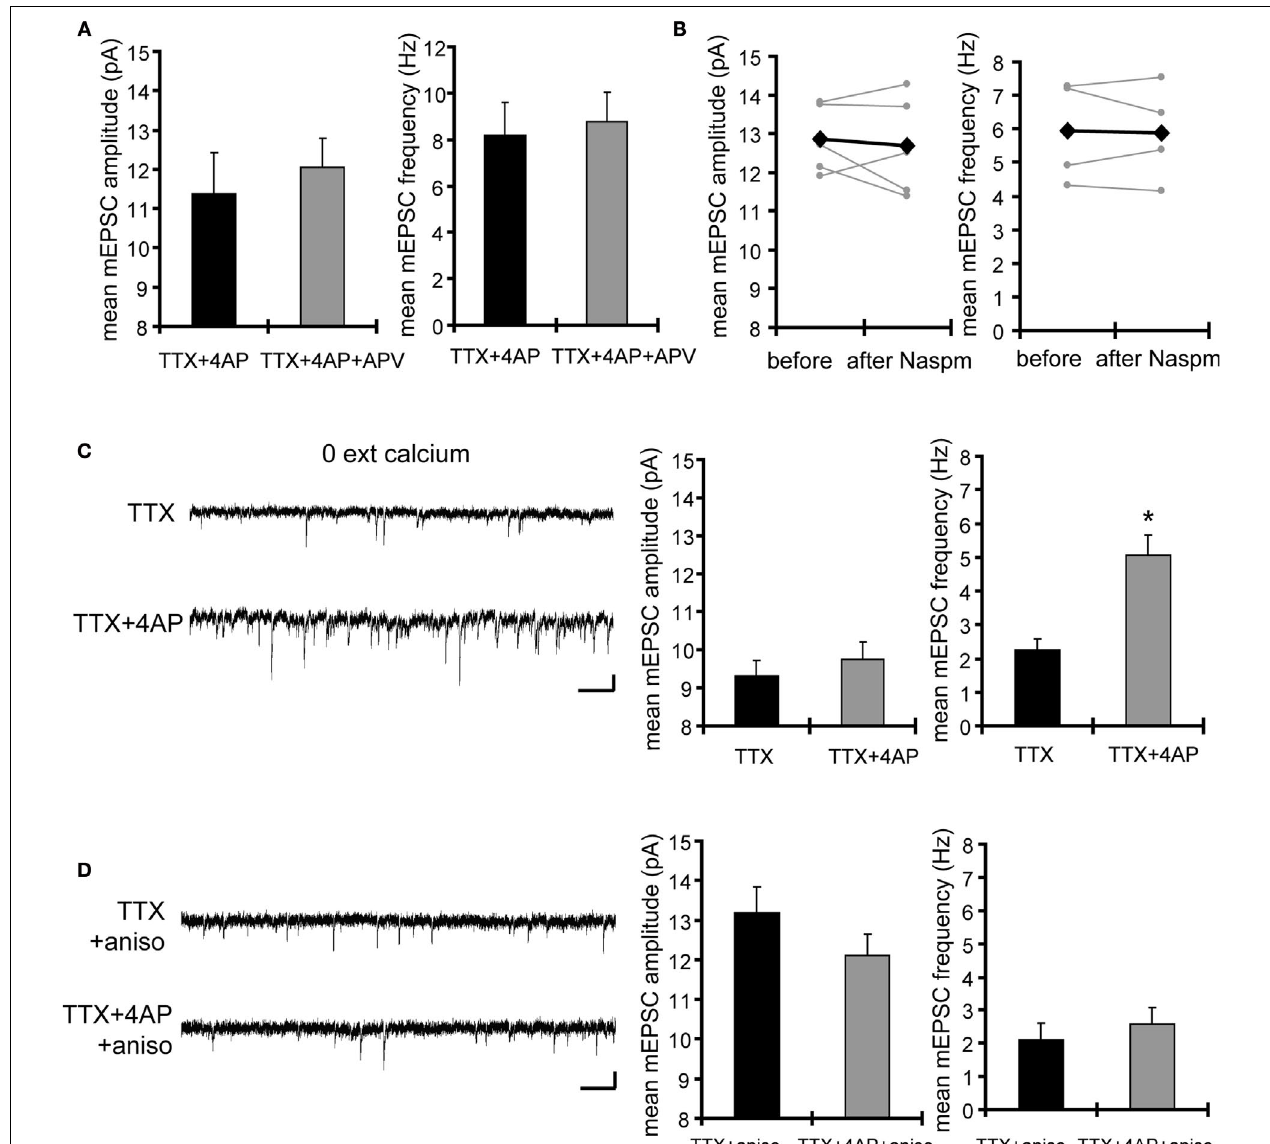
FIGURE 4 | Synaptic scaling induced by A-type channel blockade is protein synthesis dependent, but calcium-signaling independent. (A) Co-treatment with the NMDA receptor antagonist, APV (50 µM), did not infl uence synaptic scaling by A-type channel blockade ( n = 7 for each). No apparent difference in membrane properties was observed between experimental groups ( Table 1 ). (B) Synaptic scaling induced by A-type channel blockade does not require GluR2-lacking receptors. After 12-h treatment with TTX + 4AP, mEPSCs were recorded and the acute infl uence of Naspm (10 µM) application was examined. Data from individual experiments are represented by gray circles and black diamonds